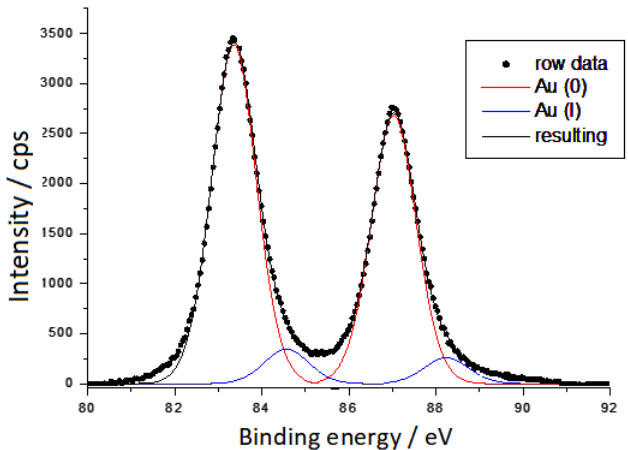
Figure 2. Au 4f doublet XPS spectral region of deposited Au nanoparticles.